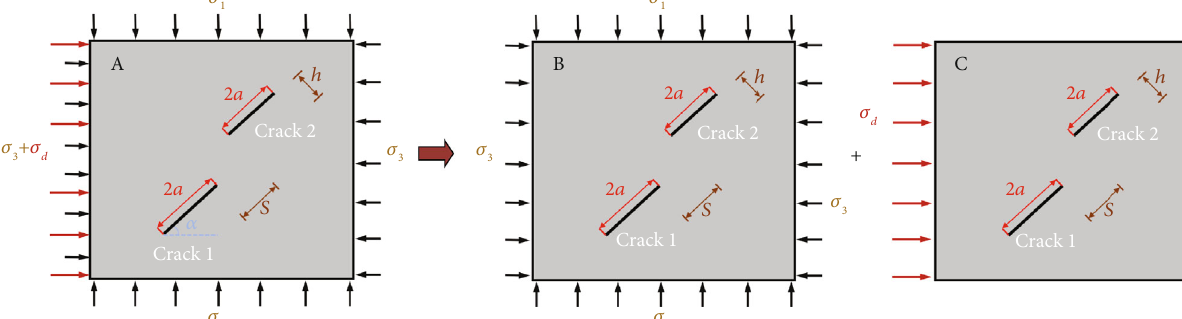
Figure 2: Superposition method of stress state of rock mass with double cracks under dynamic and static loading conditions.